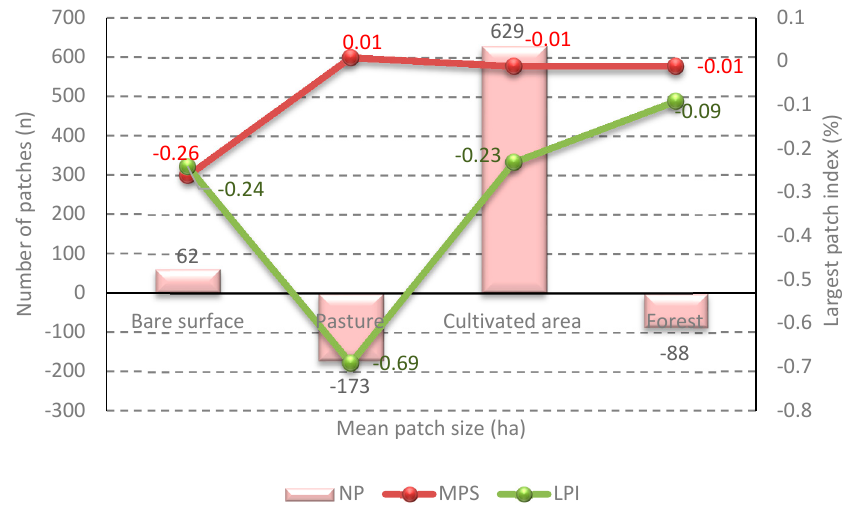
Figure 4. Gains and losses of patch number (NP), mean patch size (MPS) and largest patch index (LPI) of LULC by category in different time periods (1998–2015) in the upper part of the HSCZ.